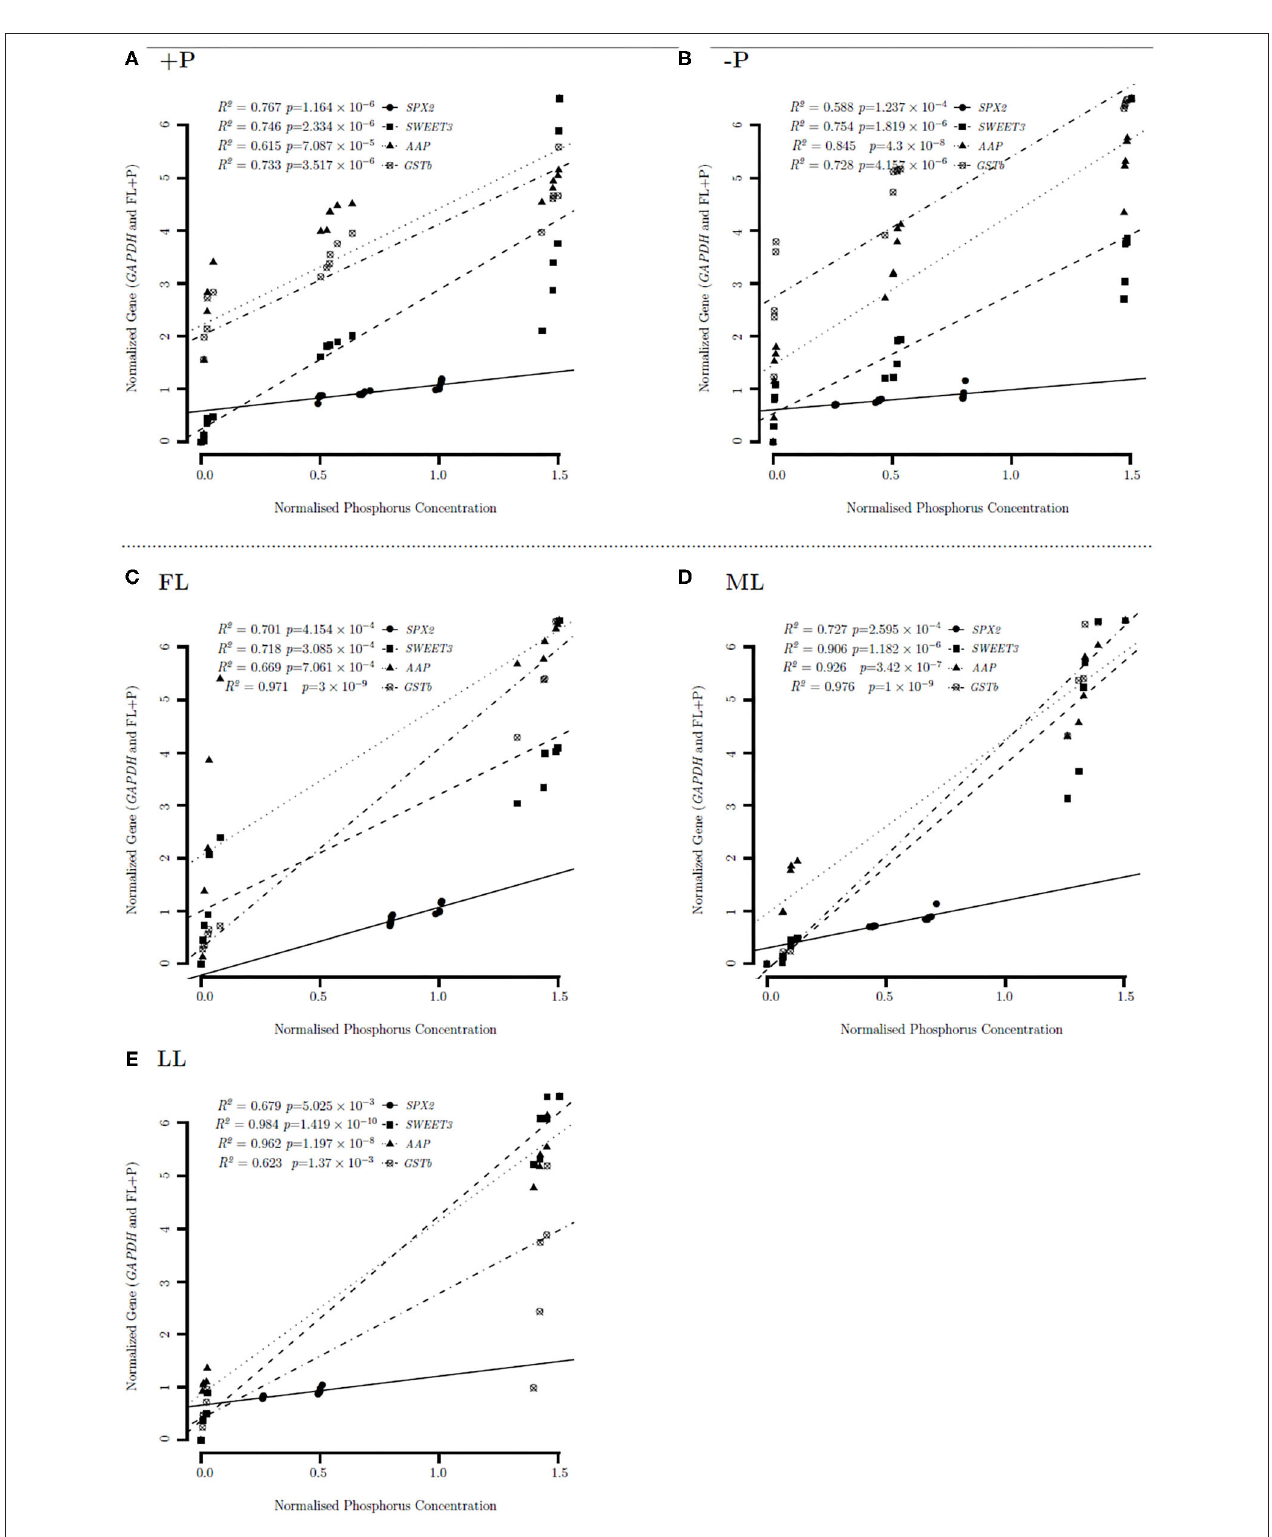
FIGURE 7 | Linear regression correlation between gene expression under different P levels (A,B) and light regimes (C–E) . High P (A) , low P (B) , full light (FL) (C) , medium light (ML) (D) , and low light (LL) (E) correlation of gene expression under different P levels and light intensities of Pi transport, stress, and signaling (SPX2) , bidirectional sugar transporter 3 ( SWEET3 ), amino acid permeases ( AAP ), and glutathione S-transferase b (GSTb) in young shoots.